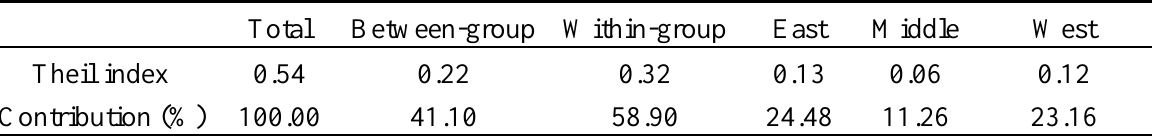
Table 2 Theil index for energy utilization efficiency across 30 case cities in